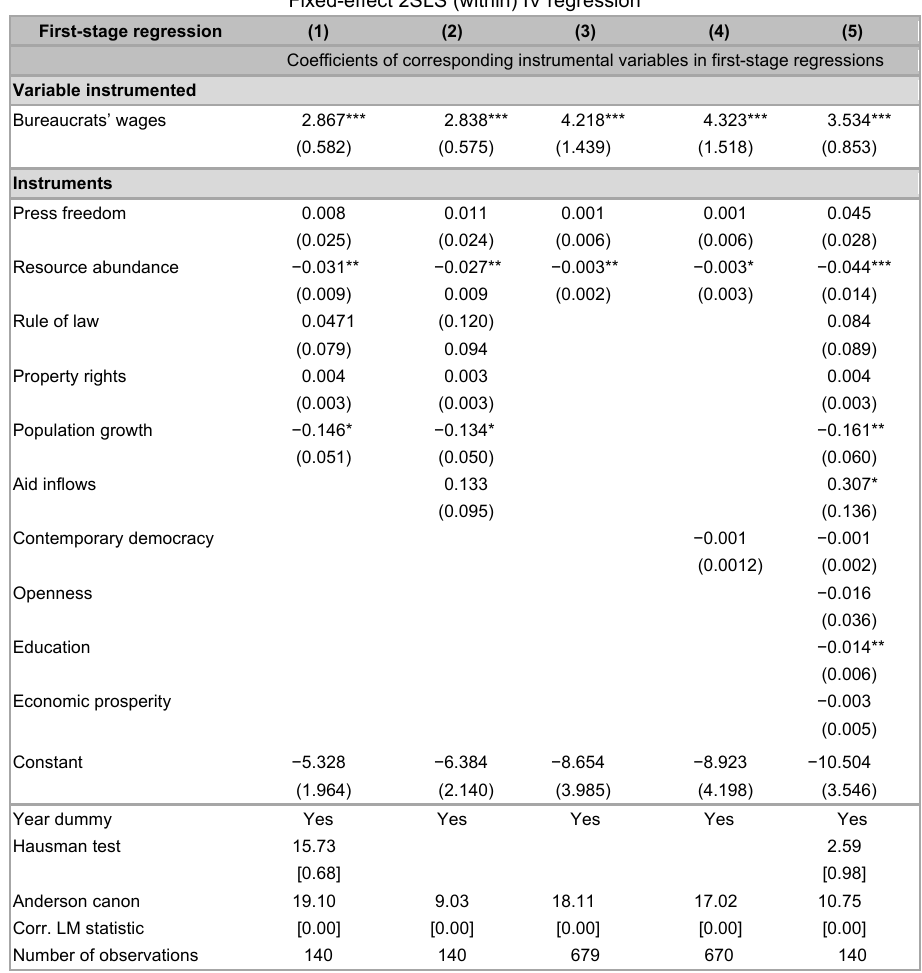
Fixed-effect 2SLS (within) IV